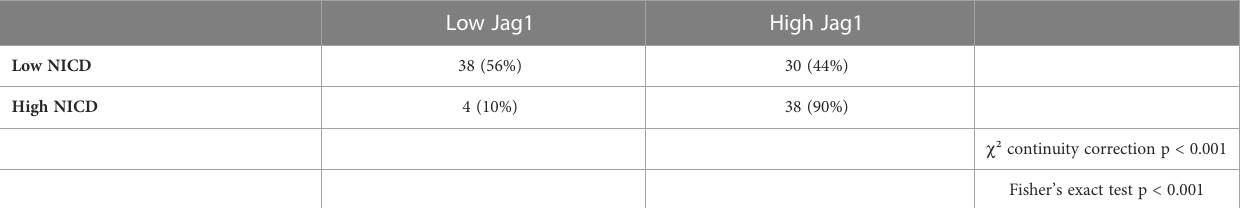
TABLE 2 Association between NICD and Jag1 expression in CRC.